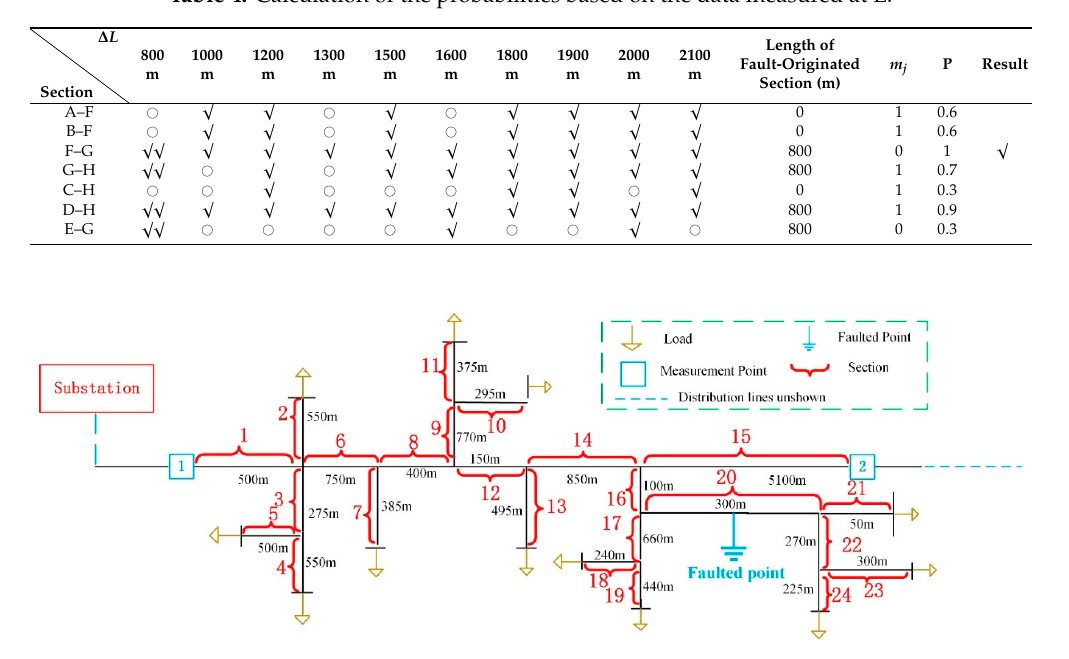
Figure 4. Simplified distribution network.